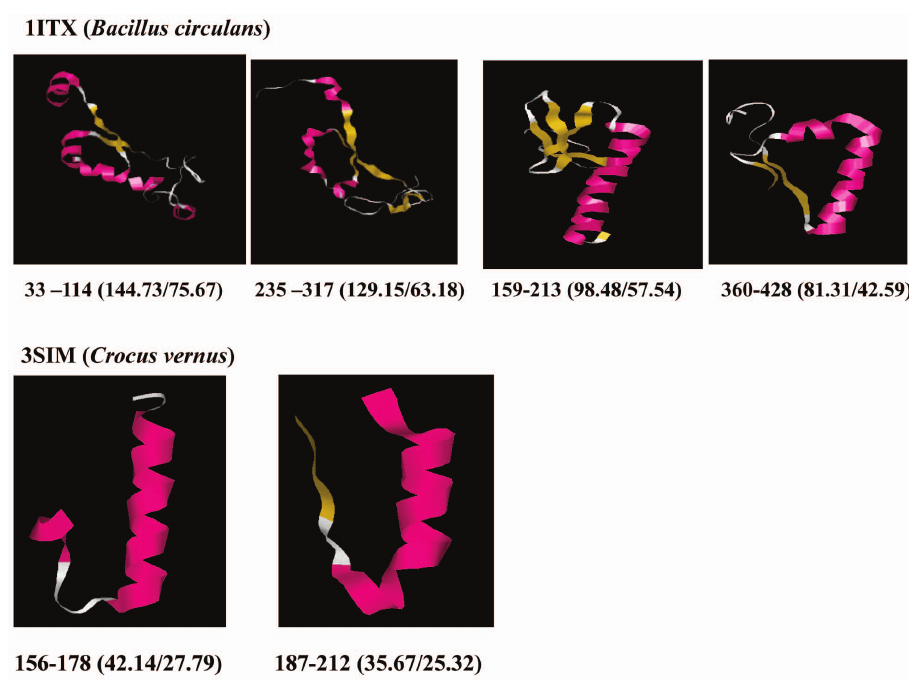
Figure 3. Visualization of internal repeats in 3-D view using RasMol.